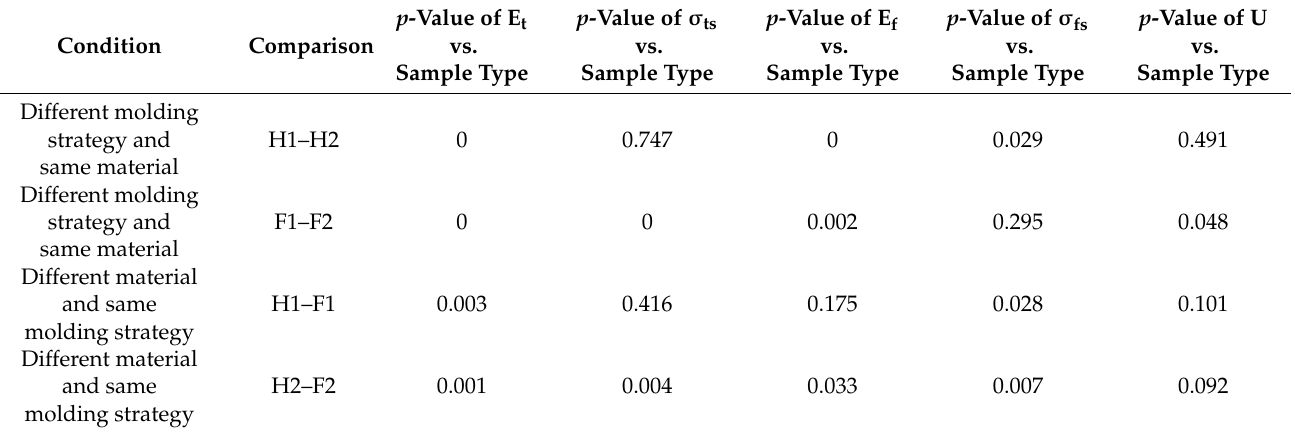
Table 2. p -values carried out from one-way ANOVA test on the results of tensile, bending and